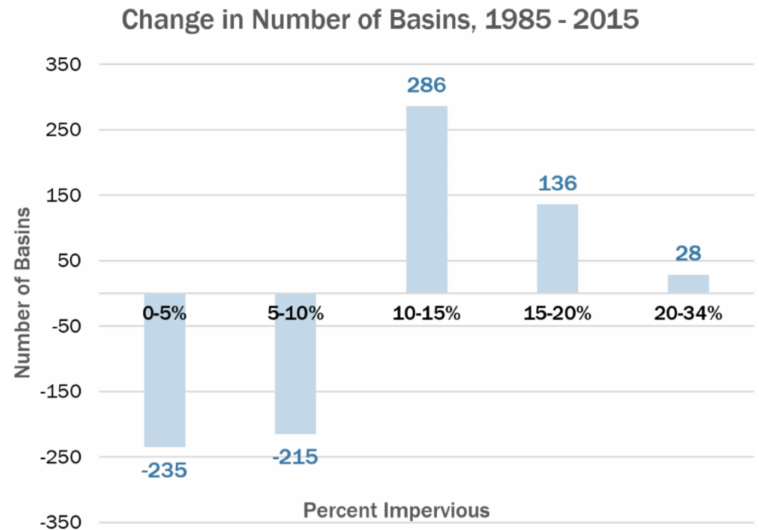
Figure 19. Distribution of 7047 small watersheds in 1985 versus 2015, in terms of levels of impervious